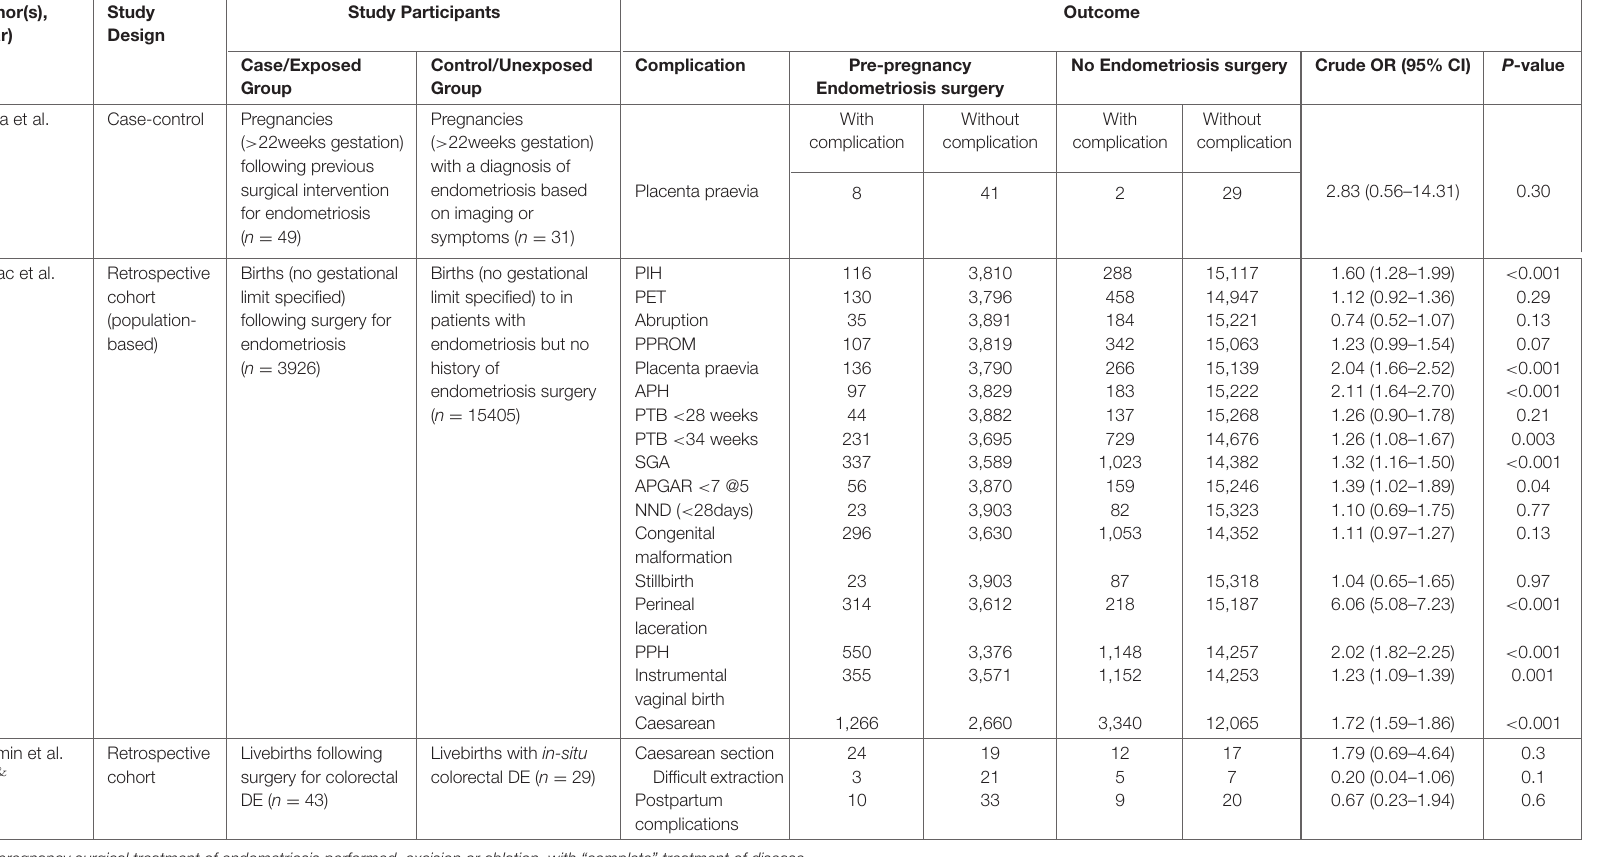
TABLE 1 | Included